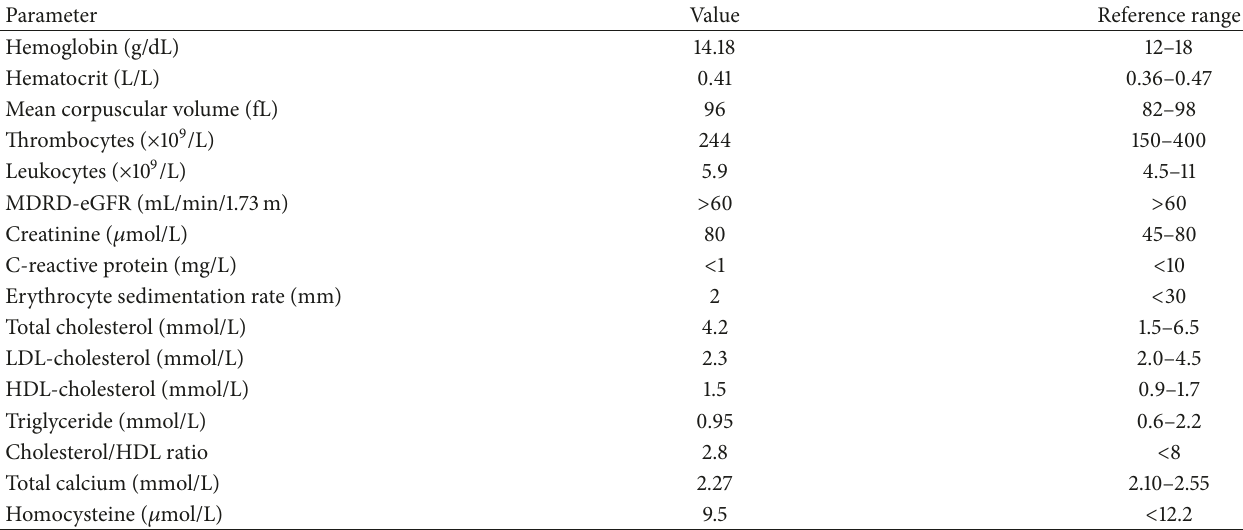
Table 1: Laboratory evaluation.